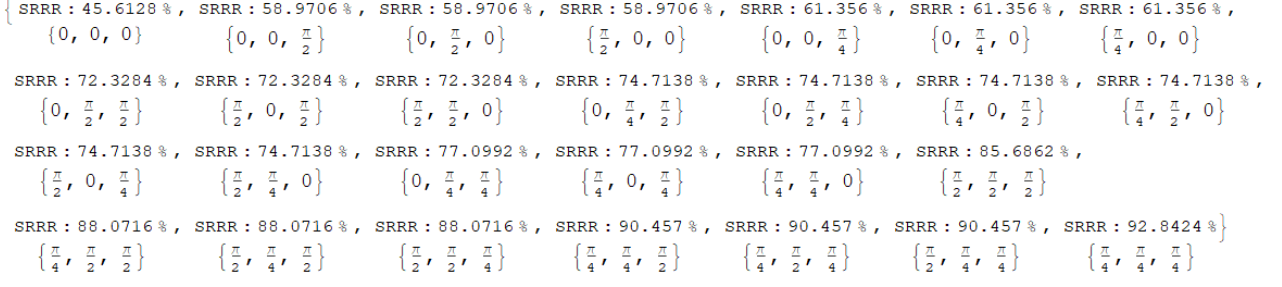
Figure 11. Solar Radiation Reception Rate for m = 3 and n = 2 at the winter solstice in the region of Makkah, Saudi Arabia.